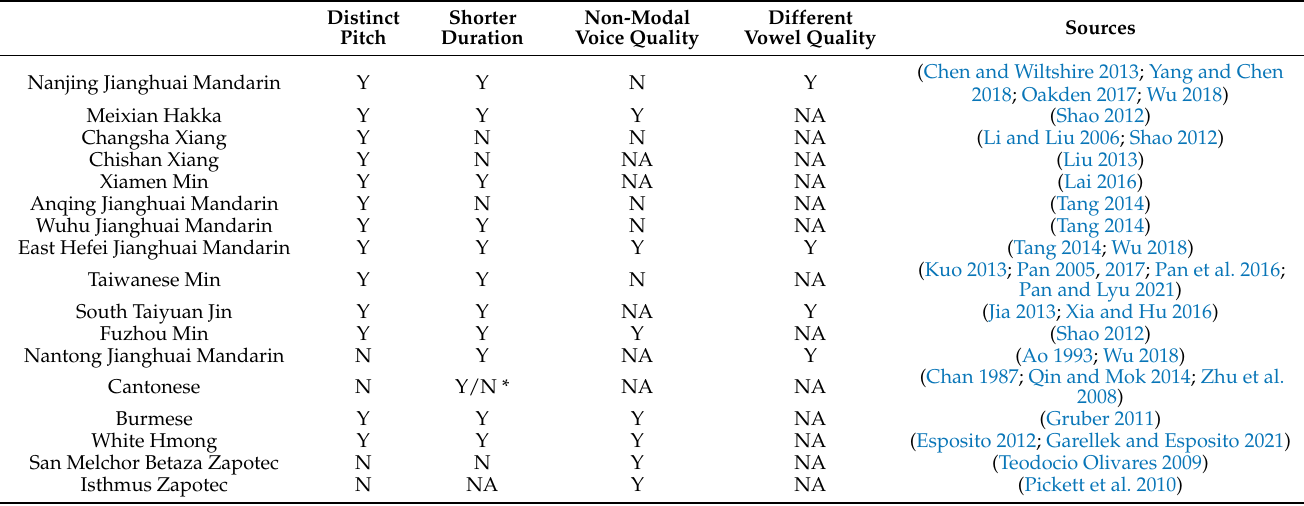
Table 3. Phonetic features of selected languages with checked constituents (Y for “Yes”; N for “No”; NA if a feature was not described in the